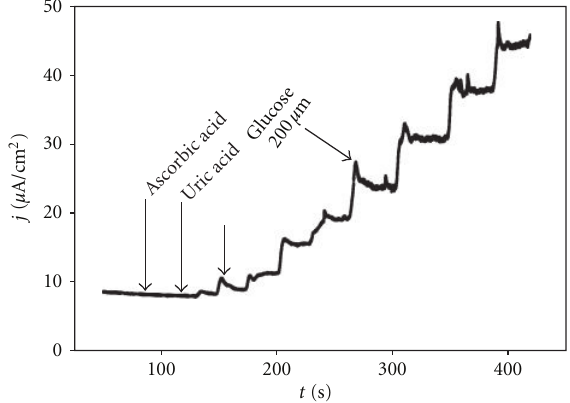
Figure 8: A typical amperometric response of the PANI-gold nanorod-enzyme biosensor after addition of 0.05mM ascorbic acid, 0.2mM uric acid, and glucose at +0.6 V versus Ag/AgCl in stirred PBS of pH